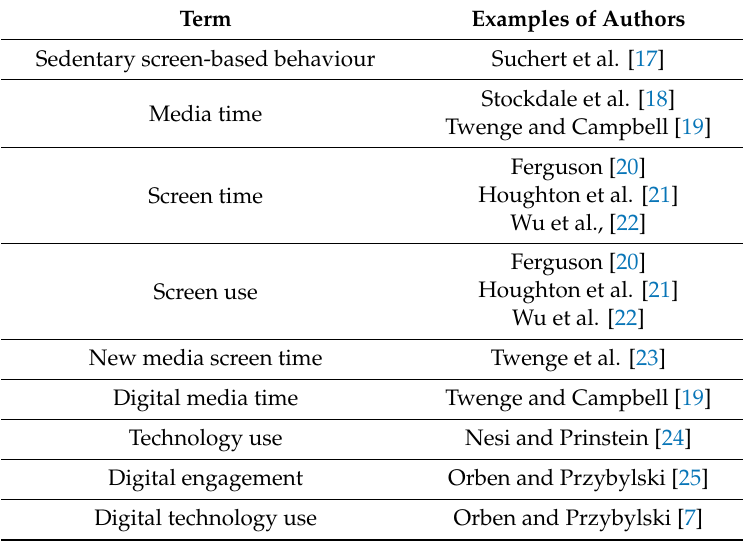
Table 1. Di ff erent terminology used in screen time